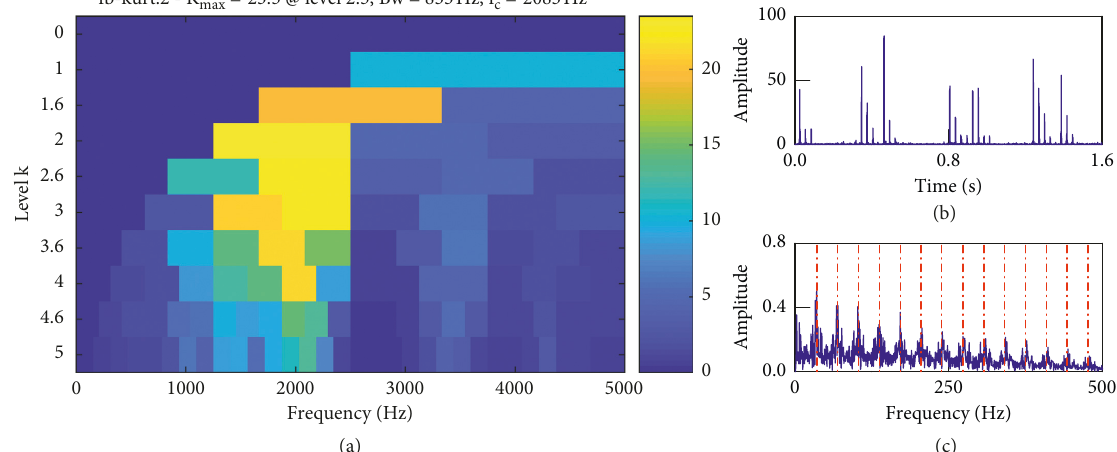
fb-kurt.2 - K max = 23.5 @ level 2.5, Bw = 833Hz, f c = 2083Hz